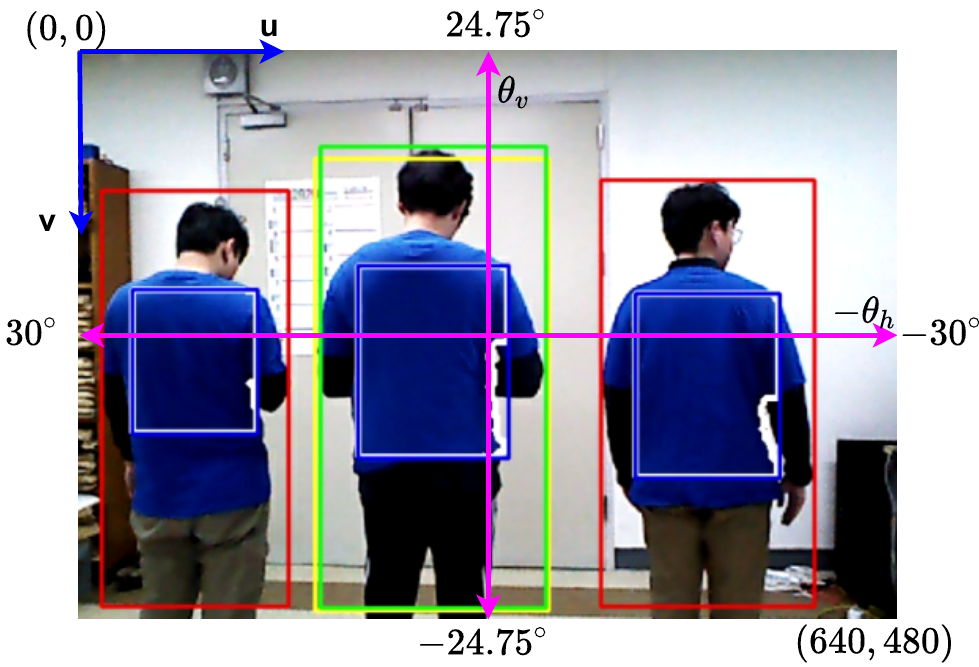
Figure 2. Human detection and color extraction within the region of